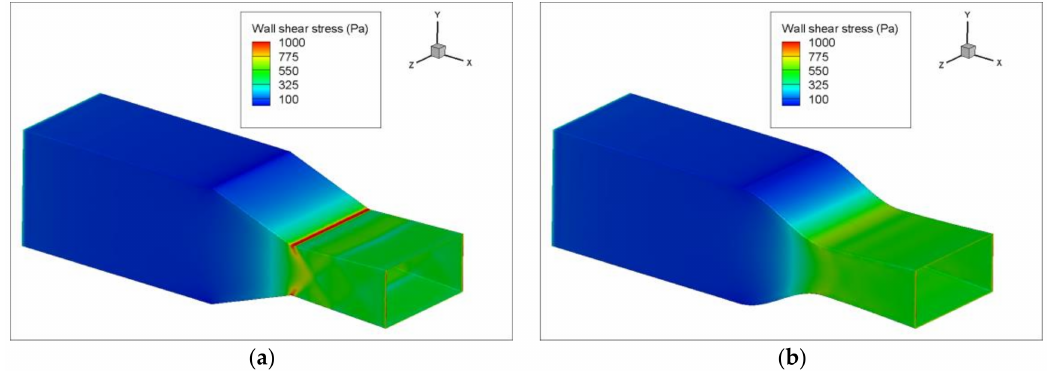
Figure 8. Wall shear stress on nozzle walls; ( a ) existing design and ( b ) improved design.